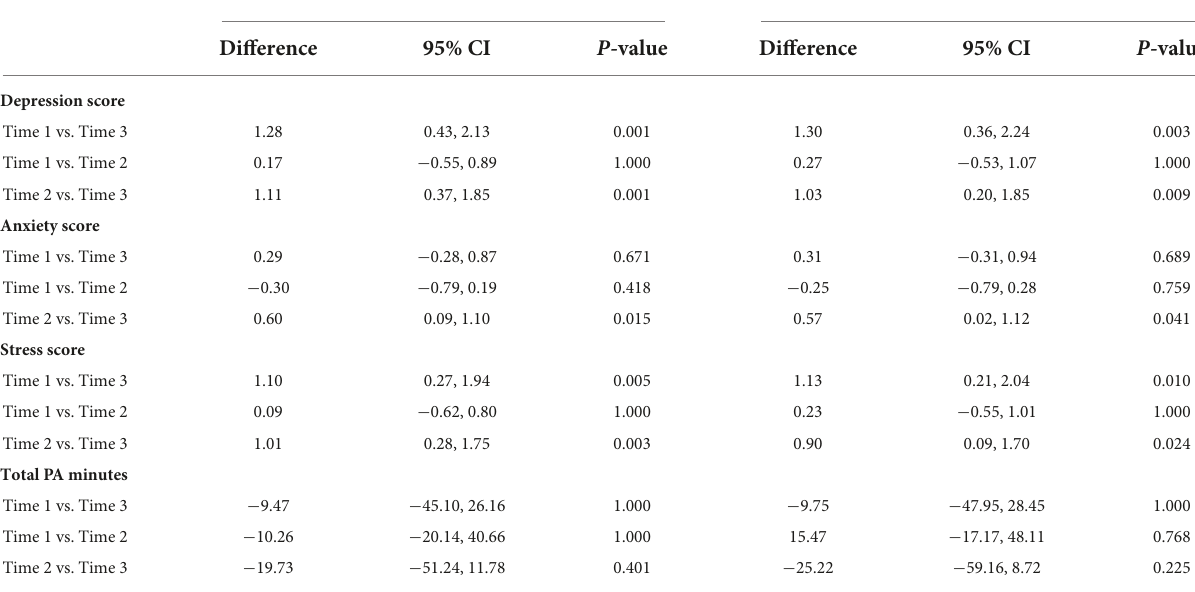
TABLE 3 Changes in mental health and physical activity in the longitudinal sample.